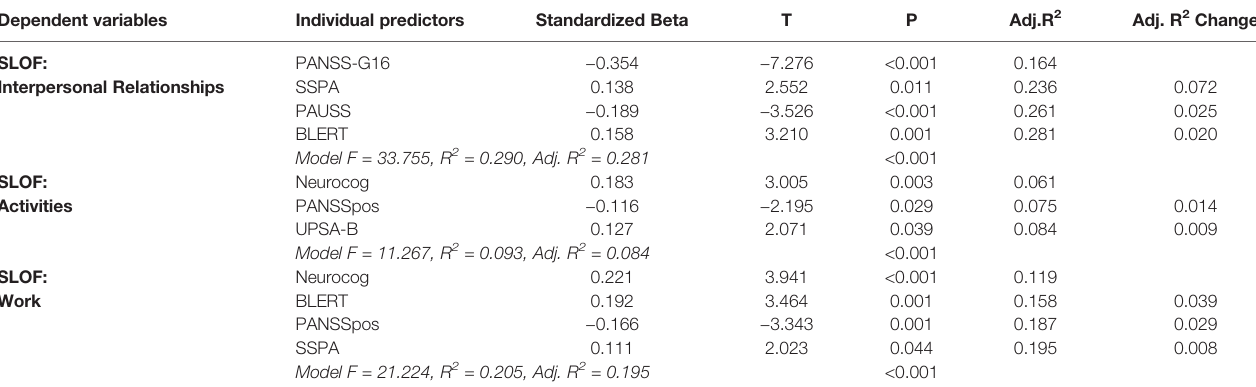
TABLE 4 | Predictors of functional outcome (Stepwise linear multivariate